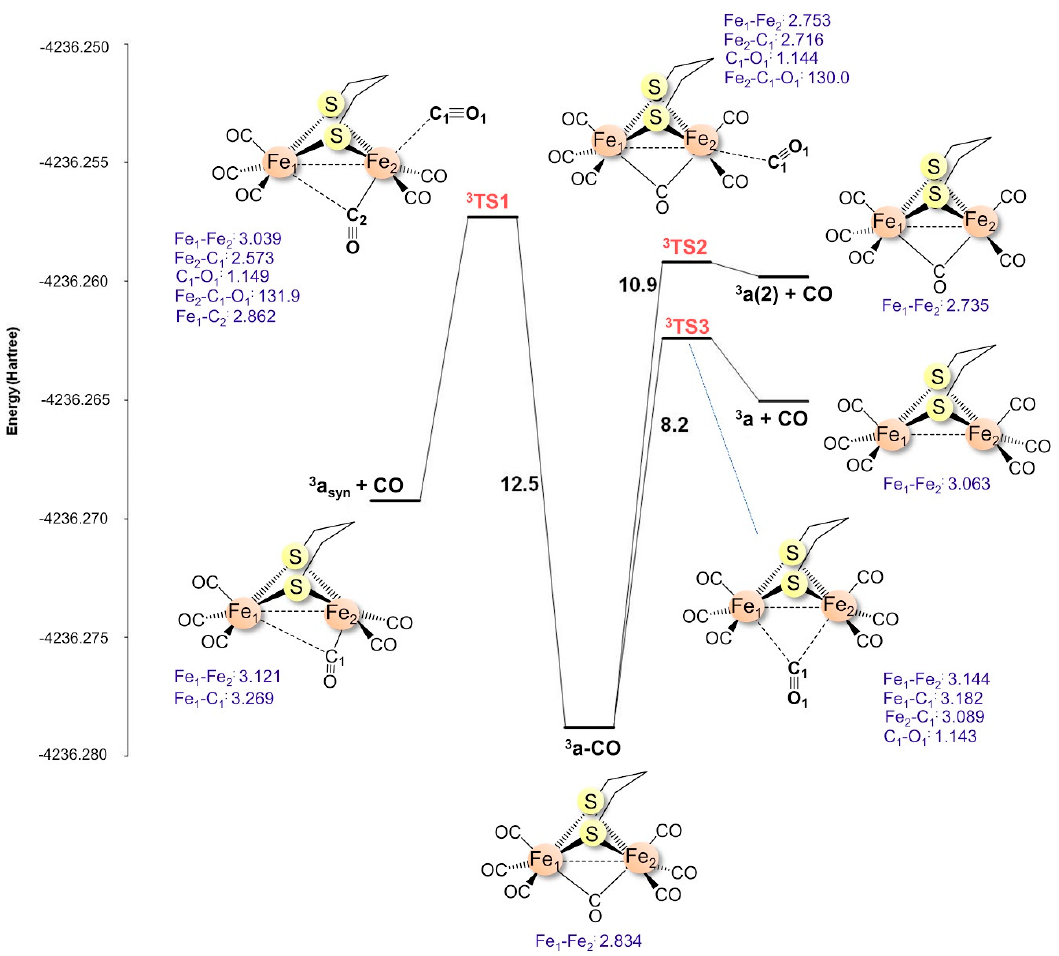
Figure 8. Total DFT energy diagram and optimized main geometry parameters of 3 a–CO and cis syn , trans syn and µ -CO CO dissociation transition states and products. The energy in Hartree and free-energy barriers in kcal · mol − 1 . Distances are in Å and angles in degrees.2.2.3 2 a + –CO 1 2 A ″ excited-state potential energy surfaces (PES) exploration.